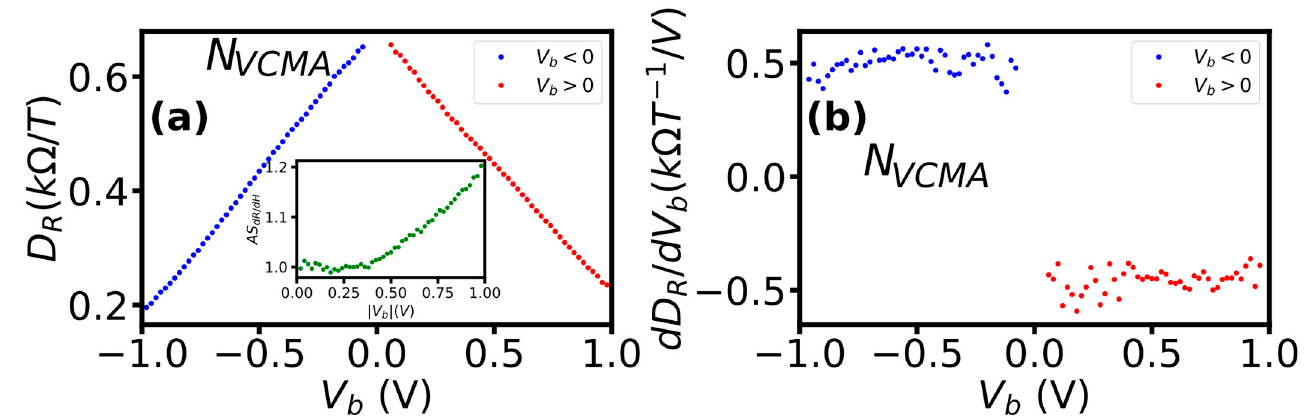
Figure 5. The influence of bias polarity on D R = dR/d μ 0 H and its symmetry (inset) ( a ) and on the rate of D R s change ( b ) of sensors without VCMA modification. The asymmetry was computed as AS dR/dH = dR/d μ 0 H(+V b )/dR/d μ 0 H( − V b ).